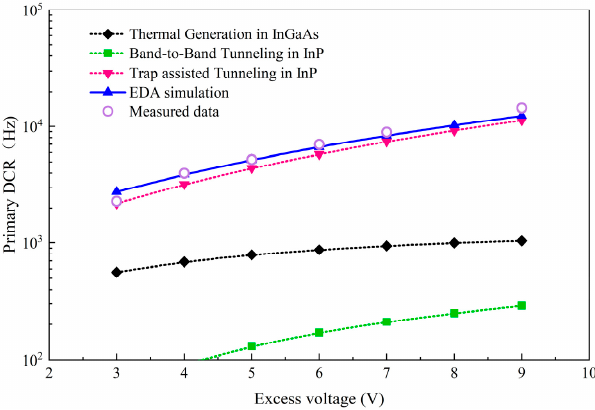
Figure 5. Simulation results of the voltage dependence of the primary dark count rate (DCR) ( T = 225 K). Figure 6 shows the simulated primary DCR as a function of the temperature with an excess voltage of 5 V. As expected, TAT and BTBT were less temperature dependent than thermal generation. Thermal generation dominated at high temperatures, but TAT was the main source of dark counts when the temperature decreased below 245 K.